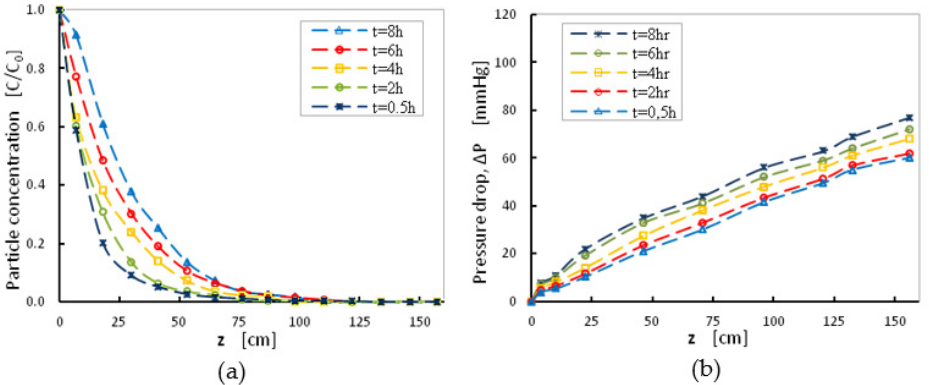
Figure 4. ( a ) Normalized particle concentration and ( b ) Pressure drop along the depth of the filter. Effect of filtration duration when V = 1.85 mm/s, sand grains with fine size distribution <1 mm and C 0 = 70NTU.